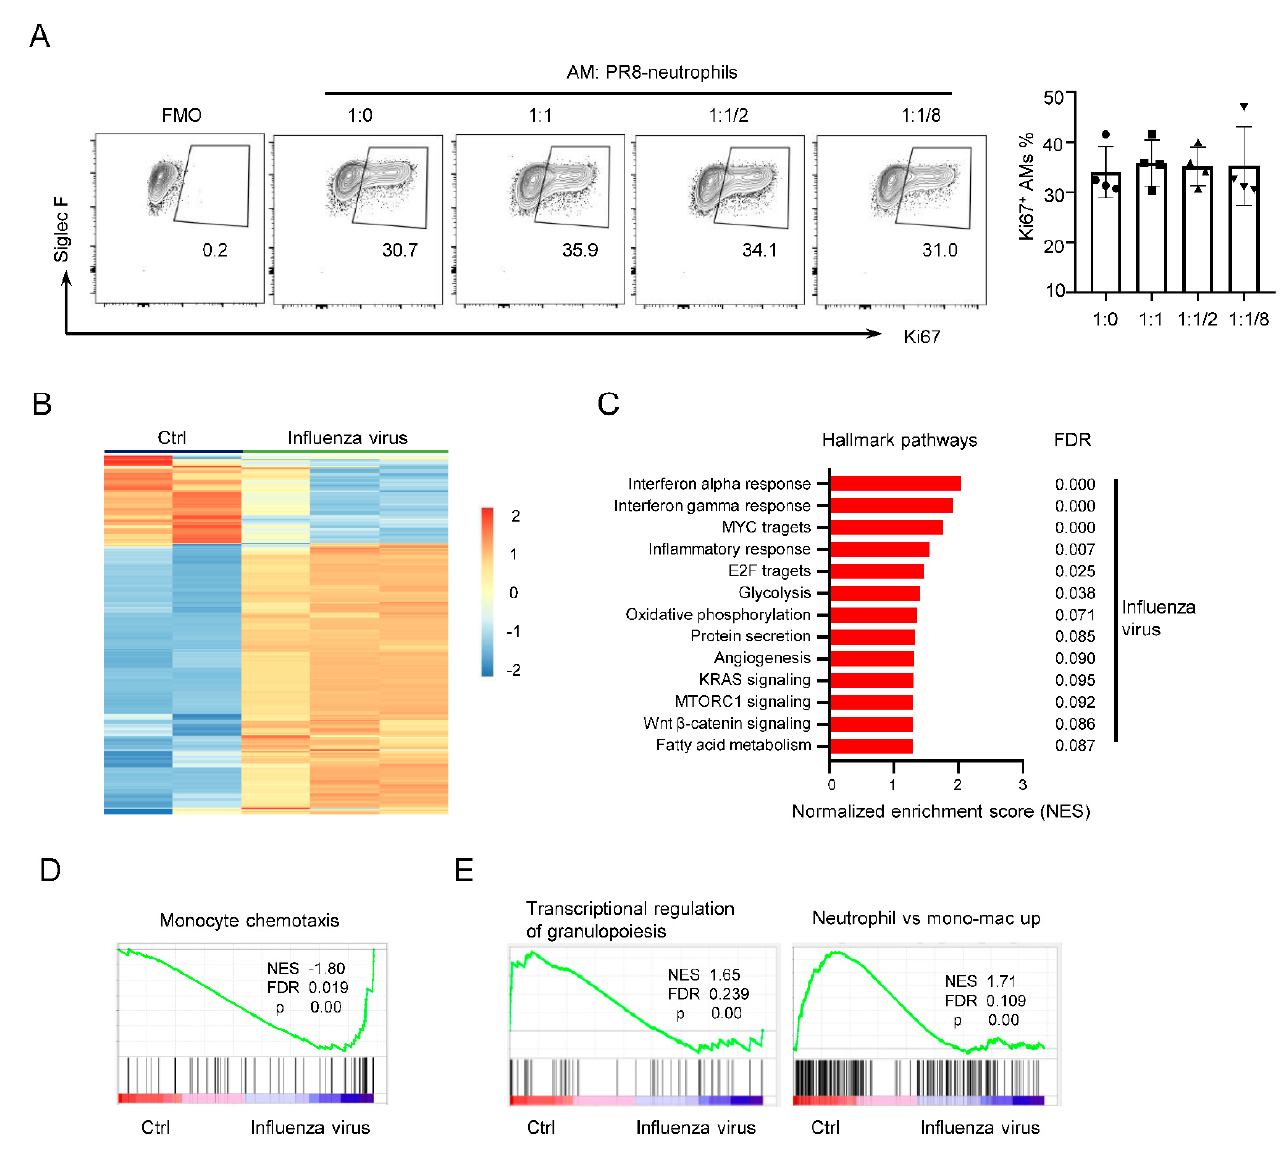
Figure 3. PR8–neutrophils do not inhibit Ki67 expression of AMs. ( A ) Representative flow cytometry plots and frequencies of Ki67 + AMs in AMs co-cultured with neutrophils isolated from BAL of PR8 infected mice (PR8–neutrophils) at the indicated ratios. ( B ) Heatmap showing 300 differentially expressed genes out of the top 500 genes in lung neutrophils in publicly available microarray dataset (GSE165299); lung neutrophils were obtained from mice without or with influenza virus at 3 day-post infection. ( C ) Normalized enrichment scores of GSEA from the hallmark gene sets in the molecular signatures database, showing the significantly enriched gene sets in GSE165299. ( D ) Enrichment plots from GSEA of infected neutrophils using gene sets for monocyte chemotaxis shown in GSE165299. ( E ) Enrichment plots from GSEA of uninfected lung neutrophils using gene sets for transcriptional regulation of granulopoiesis and neutrophil vs. mono − mac up shown in GSE165299. Data are presented as arithmetic mean ±